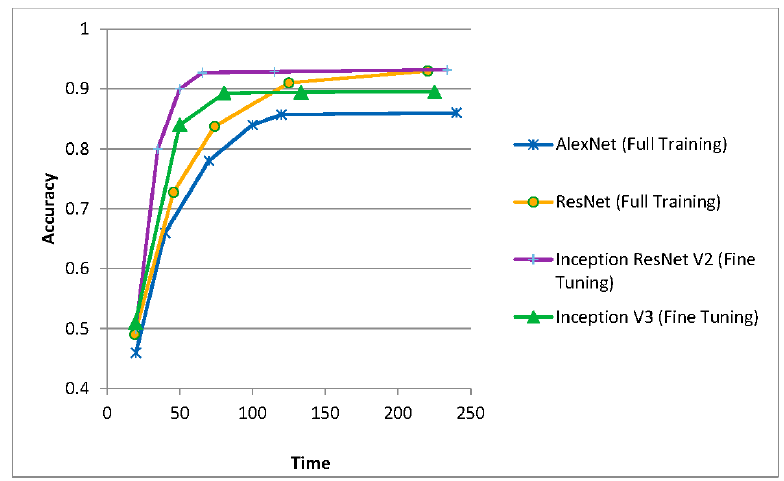
Figure 8. Comparison of the training times of the cases considered.